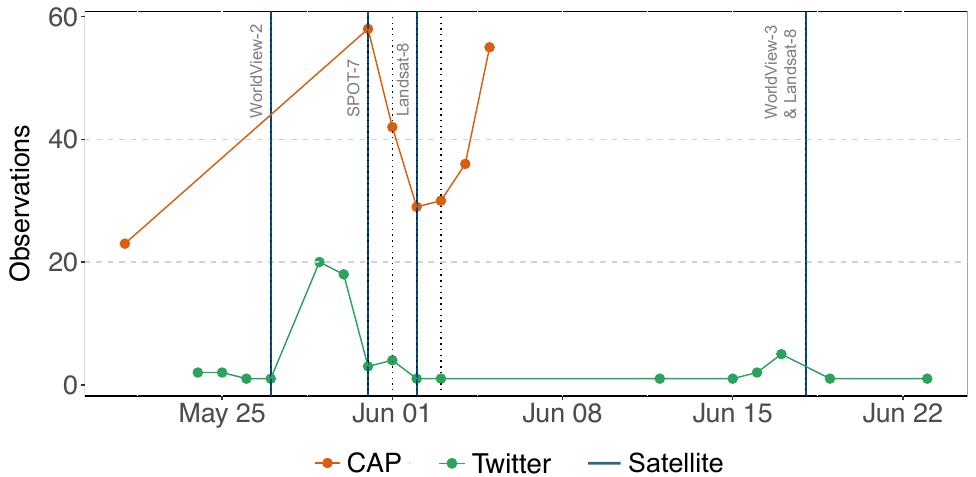
Figure 2. Summary graph of all data available during the 2015 Memorial Day flood. Vertical dotted lines represent dates for which more than one data source are available on that given